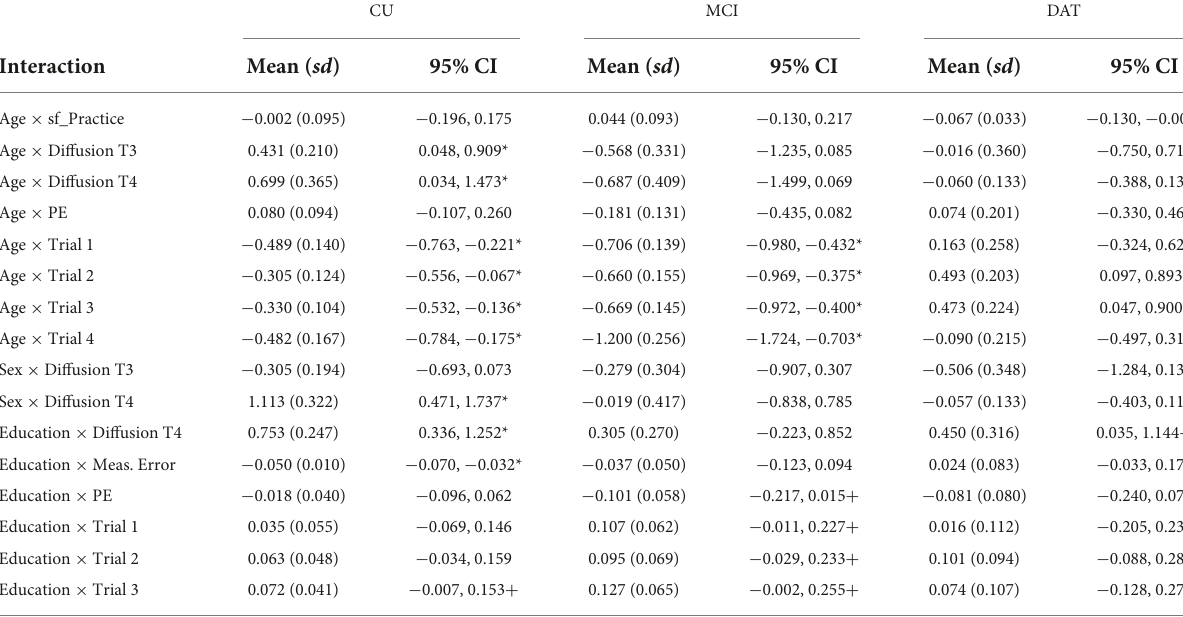
TABLE 6 Significant and trending covariate effects of participant age, sex, and education on model parameters by subgroup. CU MCI